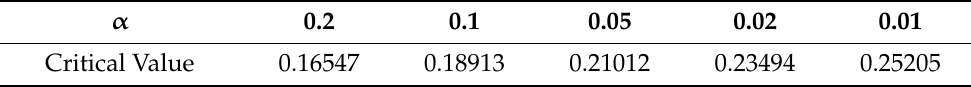
Table 7. Values used for significance level and corresponding values for critical